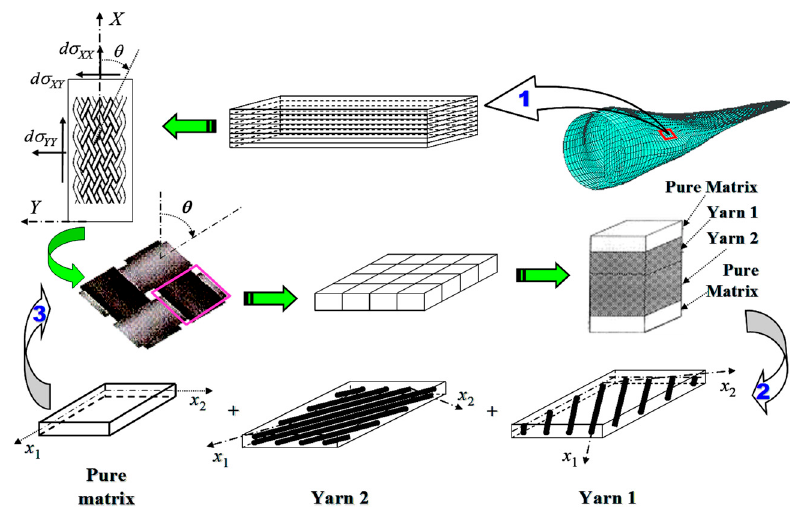
Figure 4. Analysing steps for any composite structure: 1. the structure is discretized into finite elements, and a laminate theory is applied to determine load share by each layer of the laminated element; 2. the layer is cut into a series of sheets each containing at most one straight fiber yarn segment, the bridging model is applied to determine the homogenized internal stresses and compliance tensor of each sheet, and the homogenized stresses are converted into true values as per the methods described subsequently; and 3. an assemblage from all of the sheets give the internal true stresses and compliance tensor of the layer.